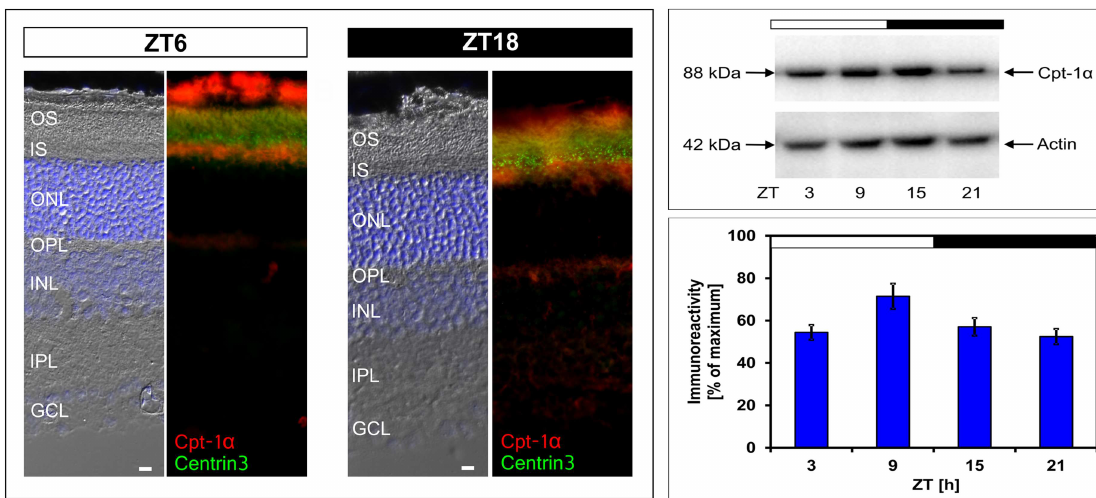
Fig 2. Localization and 24-h profiling of Cpt-1 α protein in retina. Left column: Micrographs of coronalsections of the retina, labelledfor Cpt-1 α (red) and Centrin3 (green) at Zeitgeber times (ZT) 6 and 18. The representative immunofluorescent images show that Cpt-1 α protein is primarily located in the inner segments of PRCs with no differencein the localization between ZT6 and ZT18. The upper right column shows a representative Western blot with Cpt-1 α immunostaining at about 88 kDa and β -Actin staining as a loadingcontrol. The diagram on the lower right column displaysthe quantificationof Cpt-1 α immunoreactivity in relation to the corresponding β -actin signal to which it was normalized.Data were obtained using densitometric measurement and represent percentagesof the overall maximal value. Each value represents mean ± SEM (n = 8; each n represents one animal / two retinae). The solid bars indicate the dark period. Note that Cpt-1 α immunoreactivity exhibits daily changes with peak expressionaround ZT9 ( * p < 0.05 in one-way ANOVA). OS, outer segment; IS, inner segment; ONL, outer nuclear layer; OPL, outer plexiform layer; INL, inner nuclear layer; IPL, inner plexiform layer; GCL, ganglioncell layer. Scale bar, 10 μ